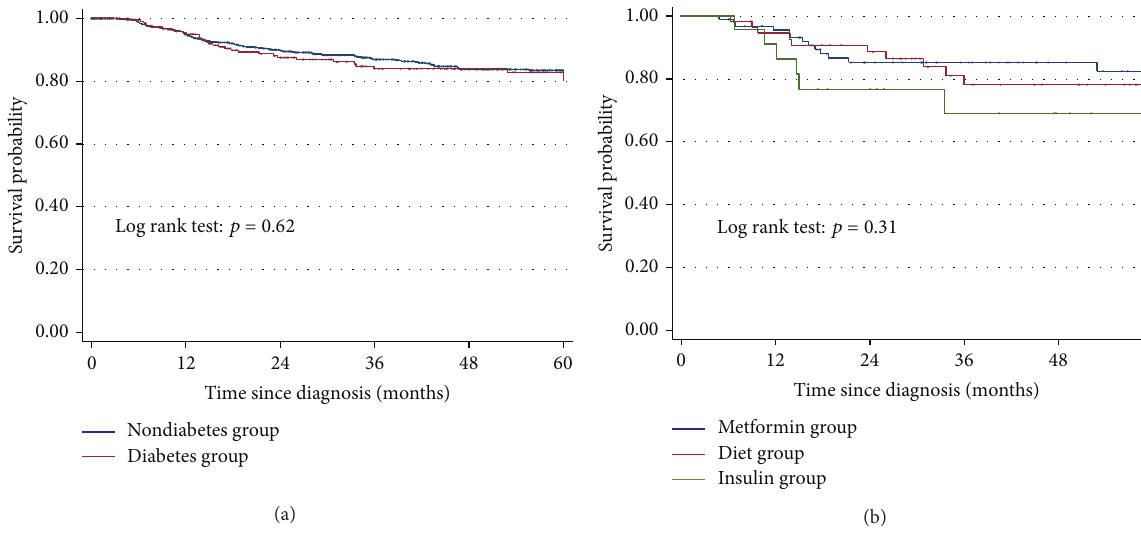
Figure 2: (a) Recurrence free survival of diabetes and nondiabetes stage II colon cancer patients. (b) Recurrence free survival of diabetes patients comparing diet alone group ( 𝑁 = 67 ) versus metformin group ( 𝑁 = 99 ) versus insulin group ( 𝑁 = 24 ).